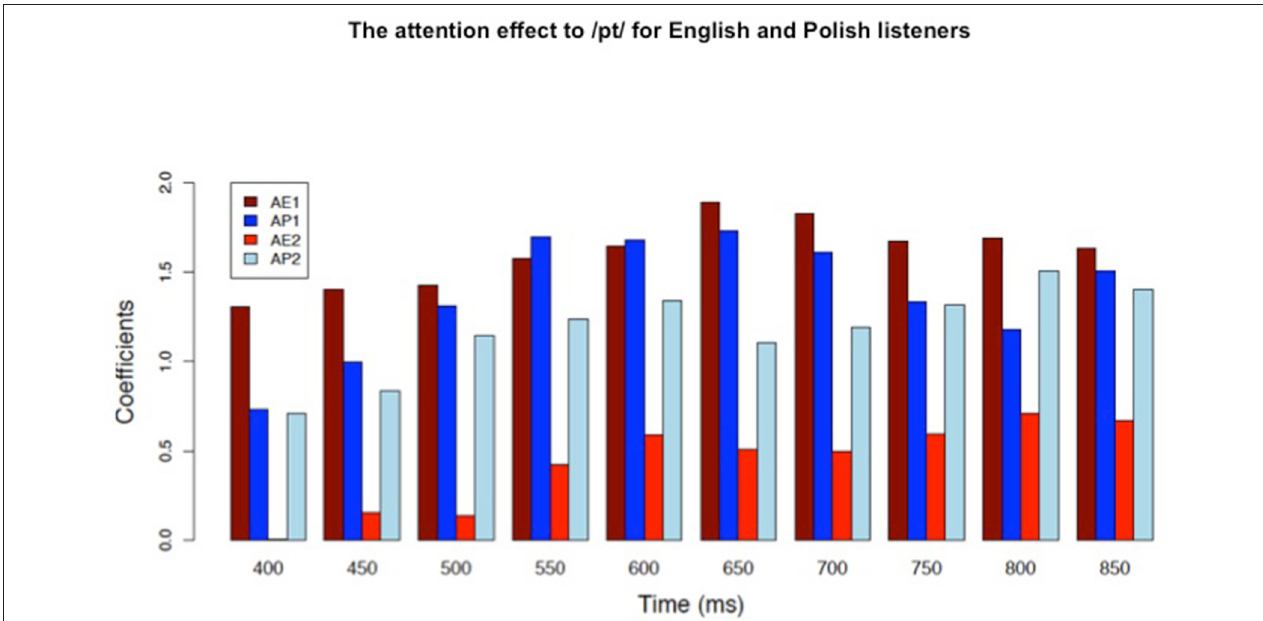
FIGURE 4 | A significant attention effect (Tukey HSD) between 400 and 900ms to the /pt/ onset was found for Polish listeners (light blue bar), but not English listeners (red bar) when the attention task was presented during testing session two (AP2, AE2). Note that the /pt/ onset is a familiar phonotactic pattern for only the Polish language group. The dark blue and brown bars indicate the significant attention effect found for both language groups to /pt/ onset when the attention task was presented during testing session one (AP1,